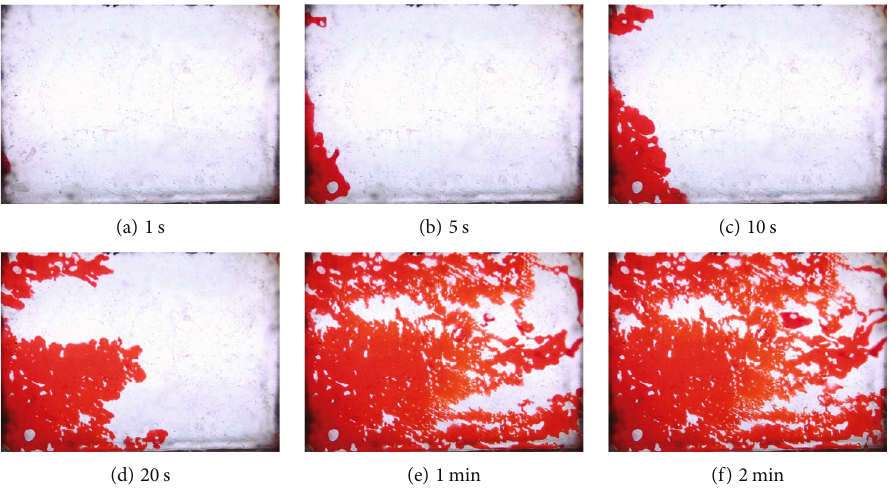
Figure 8: Migration process of PCE in the fracture model.